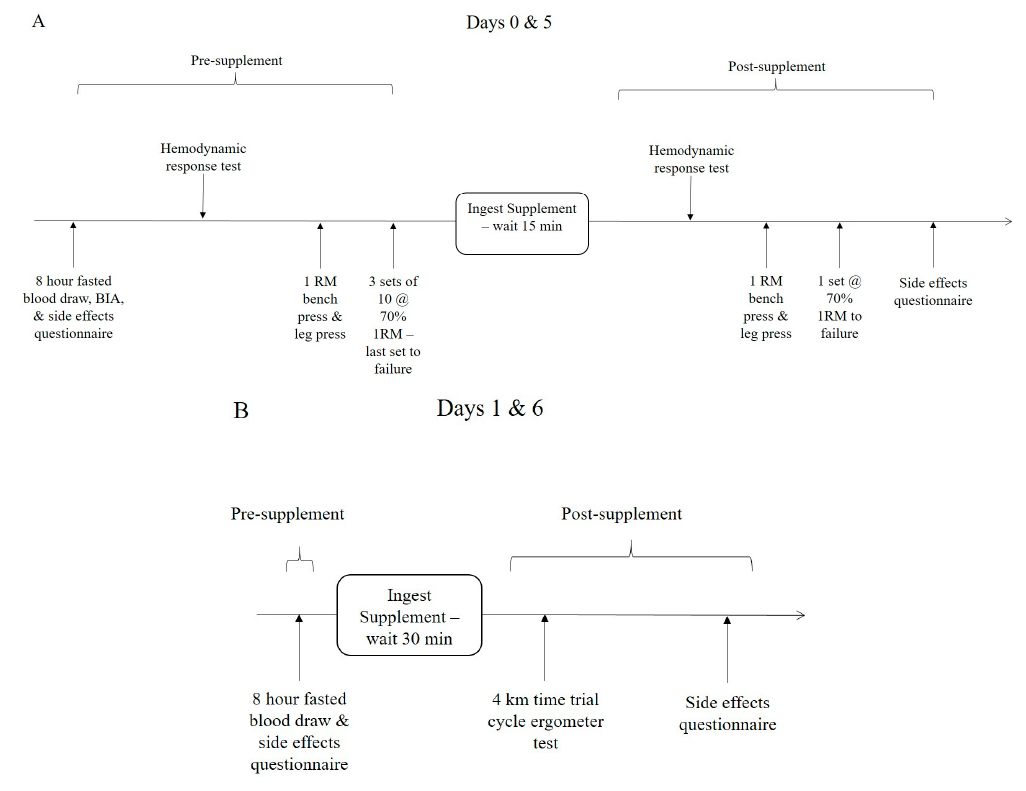
Figure 2. Testing sequence timeline. ( A ) Presents the testing sequence on days 0 and 5, while ( B ) shows the testing sequence on days 1 and 6 of